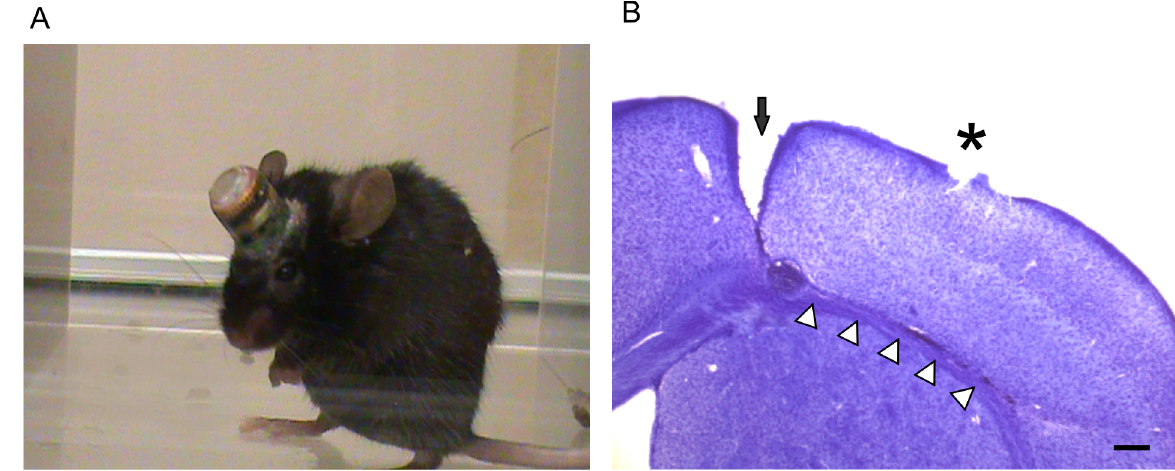
Fig 1. Chronic electroencephalography (EEG) monitoring with a telemetry system in undercut mice. (A). A mouse that was chronically implanted with a miniature transmitter showed normal behaviors during the monitoring period. (B). Histological verification of undercut lesion and recording site with Cresyl violet staining. A coronal brain section shows a continuous transcortical cut (black arrow) and an undercut (white triangles) lesion at 8 weeks after undercut surgery and the recording site located on the pial surface above the undercut lesion (asterisk). Scale bar in (B): 200 μ